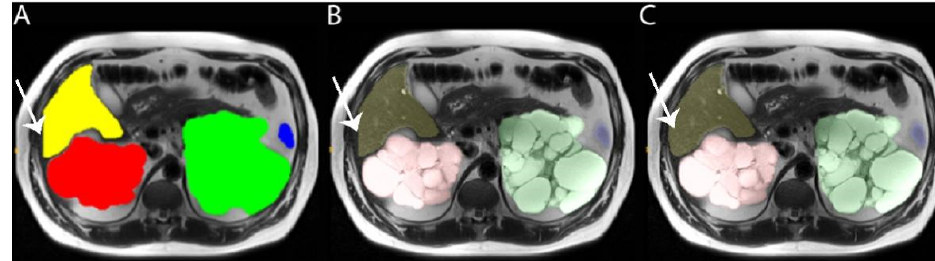
Figure 3. Axial T2 weighted image from a 59-year-old male with ADPKD showing: ( A ) model correctly labeling right kidney (red), left kidney (green), spleen (blue) and liver (yellow) except that inference cropping causes an incorrectly straight liver label border (white arrow). ( B ) with partial label transparency, the underlying organs are visualized with numerous cysts in both right and left kidneys (red and green), including the incorrectly straight liver label border (white arrow). ( C ) after removing the cropping step from the inference input, the liver border is correctly labeled without cropping (white arrow).